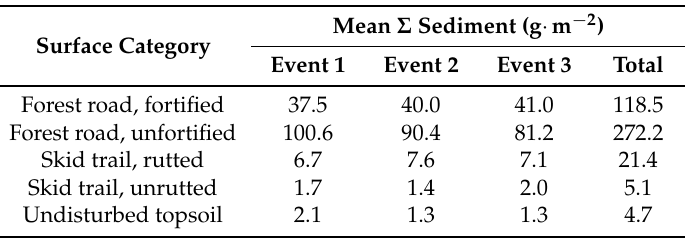
Table 9. Mean sums of sediment eroded from different surface categories during three consecutive rainfall